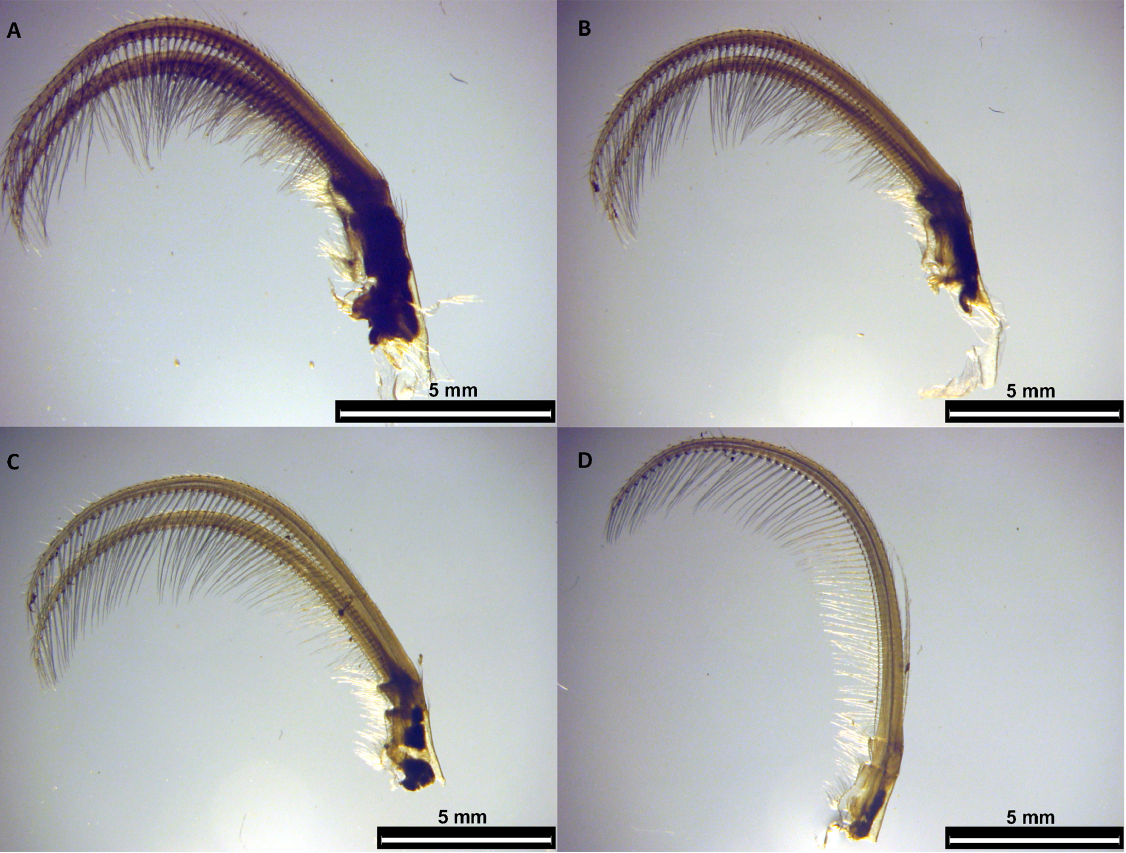
Fig. 6. Pictures of Heteralepas gettysburgensis sp. nov. (holotype) A . Cirrus II. B Cirrus III. C . Cirrus IV. D . Cirrus